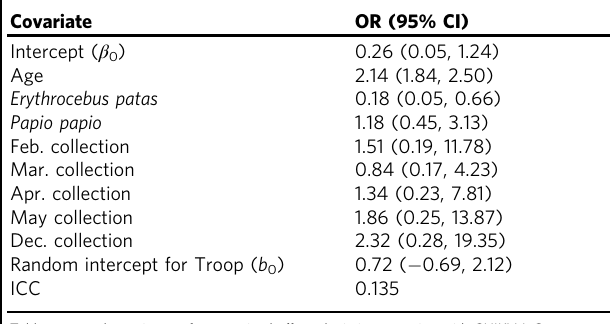
Table 2 Mixed effects logistic regression